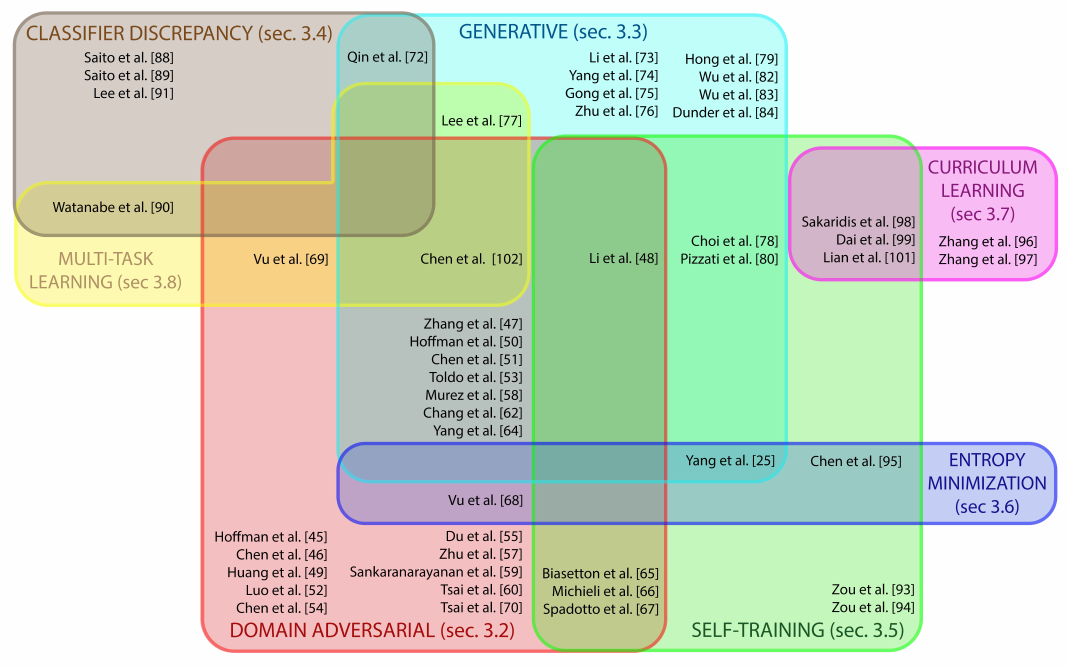
Figure 6. Venn diagram of the most popular UDA strategies for semantic segmentation. Each method falls in the set representing the adaptation techniques used. (Best viewed in